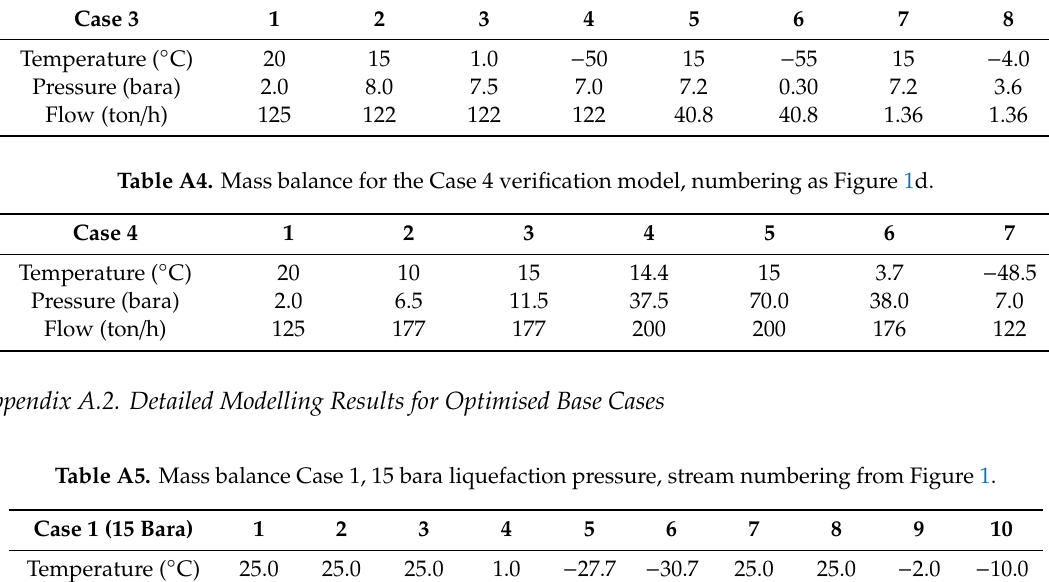
Table A3. Mass balance for the Case 3 verification model, numbering as Figure 1c.